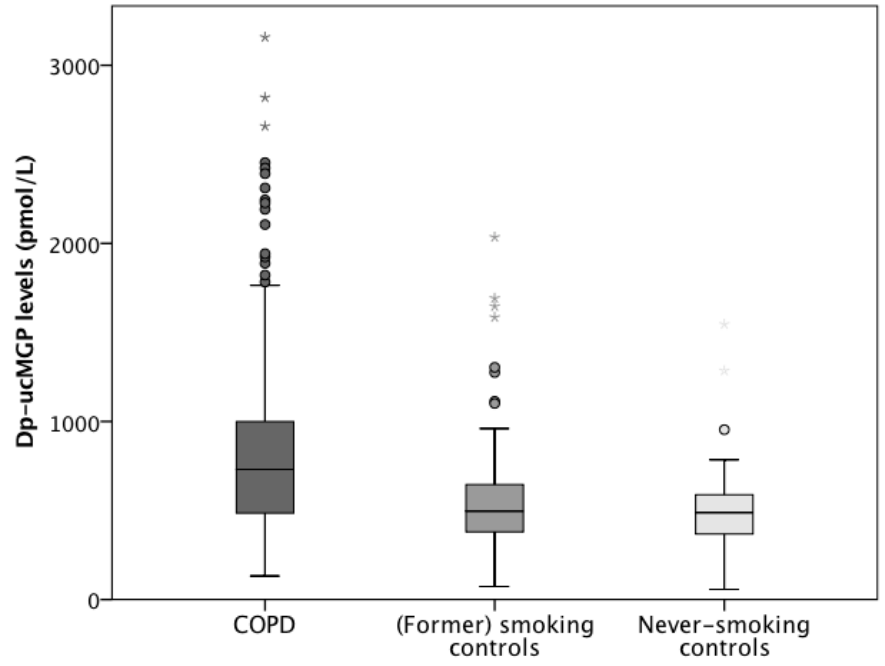
Figure 2. Boxplots (5th percentile, 1st quartile, median, 3rd quartile, and 95th percentile) showing a significant difference in plasma desphospho-uncarboxylated Matrix Gla Protein levels between COPD patients (dark grey), (former) smoking control subjects (middle grey) and never-smoking control subjects (light grey) in the ICE-Age study. Outliers are presented as points and extreme outliers as asterisks.